Question: Condense the content of this figure into a single sentence.
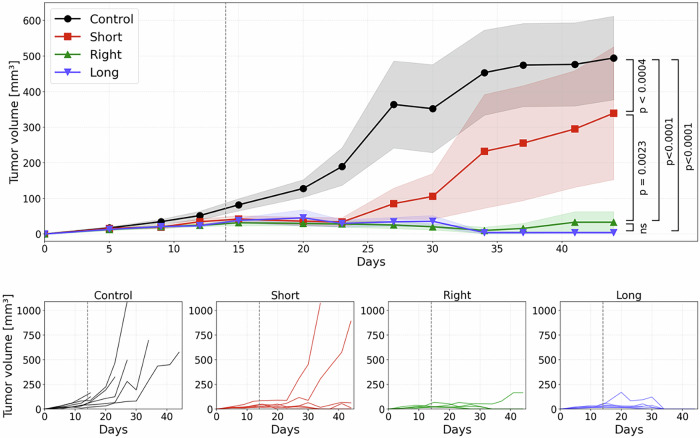
Answer: Tumor growth curves. The upper panel shows the average tumour volumes calculated from caliper measurements taken twice a week starting from the injection day (see Methods for details). The vertical grey line indicates the irradiation day. Individual tumour growth curves for the animals of the different treatment groups are shown in the lower panels. The groups are: 0 Gy tumour-bearing mice (black circle symbols, n = 7 animals), 20 Gy Short (S) range group (red square symbols, n = 6), 20 Gy Right (R) range group (green upward triangle symbols, n = 5), and 20 Gy Long (L) range group (blue downward triangle symbols, n = 6). Shaded areas of respective colors represent the regions of the standard errors of the mean for every group. During the observation period of 28 days, the animals reaching the permitted burden had to be sacrificed according to the ethical protocol; in such cases, the last measured tumor size was kept for subsequent calculations of the group-averaged tumor sizes. Growth trends were compared via the two-way ANOVA statistical test, and resulting p -values are displayed next to the respective bars.